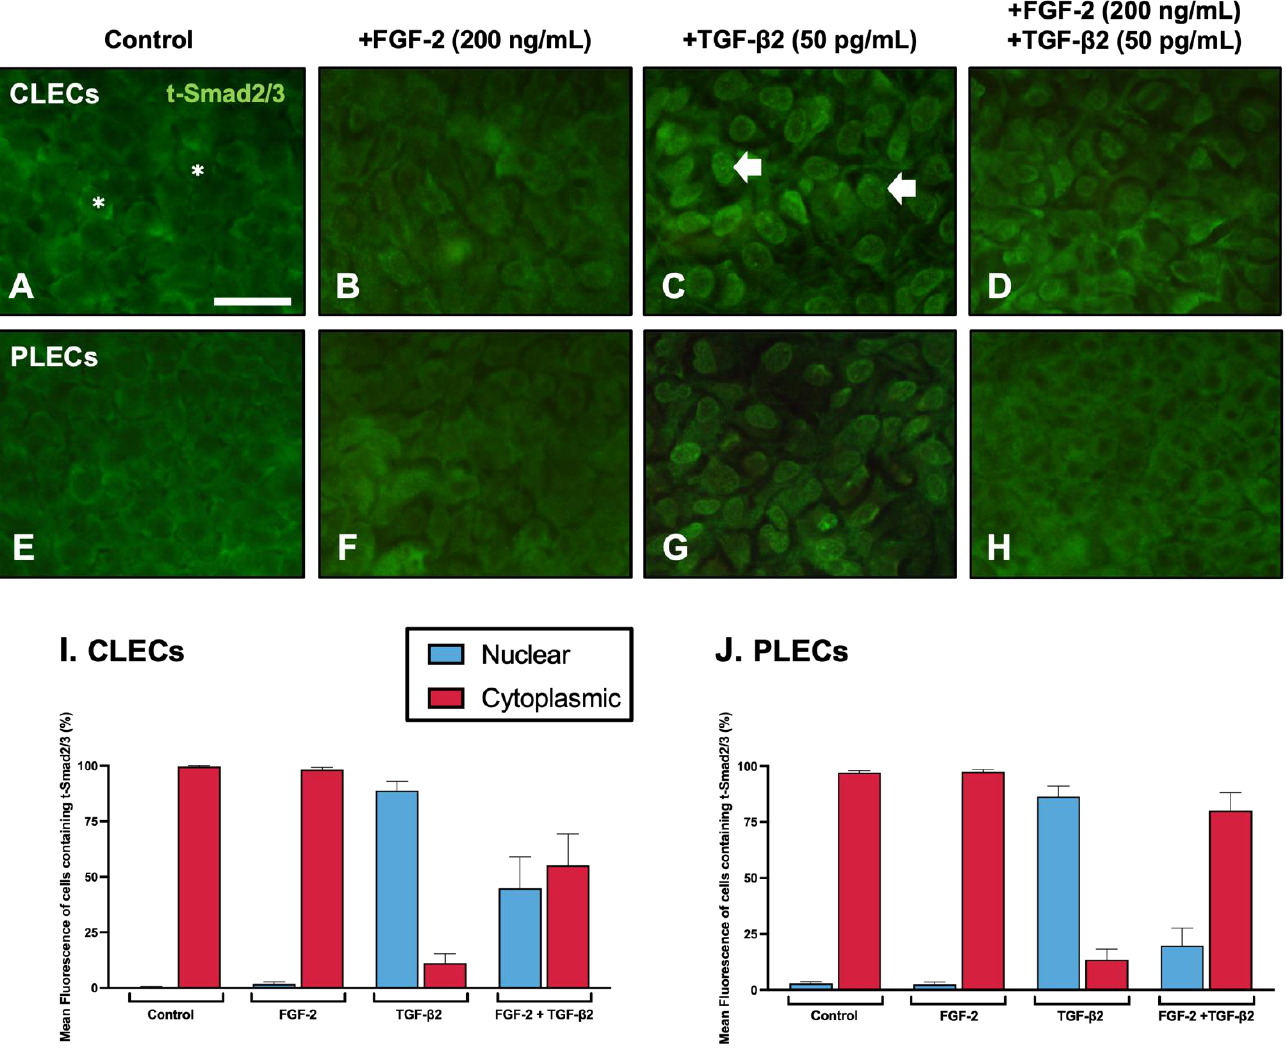
Figure 5. FGF-2 modulates TGF β -2-induced Smad2/3 nuclear translocation. Immunolabelling of total Smad2/3 (t-Smad2/3, green) in LEC explants following two hours of culture ( A – H ). CLECs ( A – D ) and PLECs ( E – H ) in explants treated with no growth factors (control; A , E ), FGF-2 (200 ng/mL; B , F ), TGF- β2 (50 pg/mL; C , G ), or cotreated with FGF-2/TGF- β2 ( D , H ). Examples of cytosolic (asterisks) and nuclear (arrowheads) localisation. Mean percentage (± SEM) fluorescence of cells with nuclear (blue) and cytoplasmic (red) t-Smad2/3 localisation in CLECs ( I ) and PLECs ( J ). Scale bar: 50 μ m.